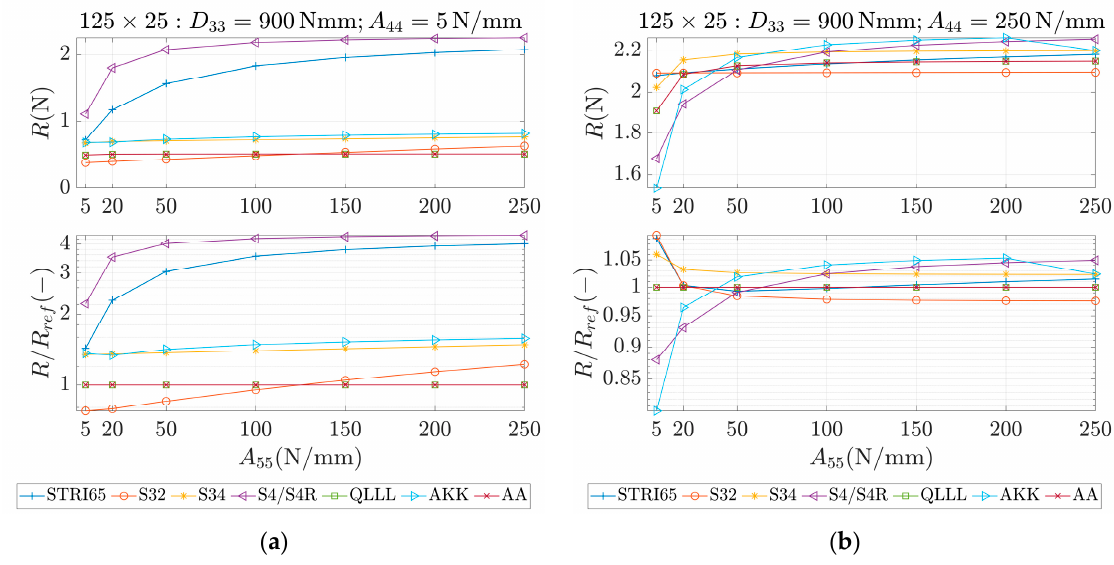
Figure 12. Reactions (first row) and reactions to the reference (analytical) solution (second row) for 125 × 25 sample, D 33 = 900 Nmm and different values of A 55 . ( a ) A 44 = 5 N / mm and ( b ) A 44 = 250 N / mm.